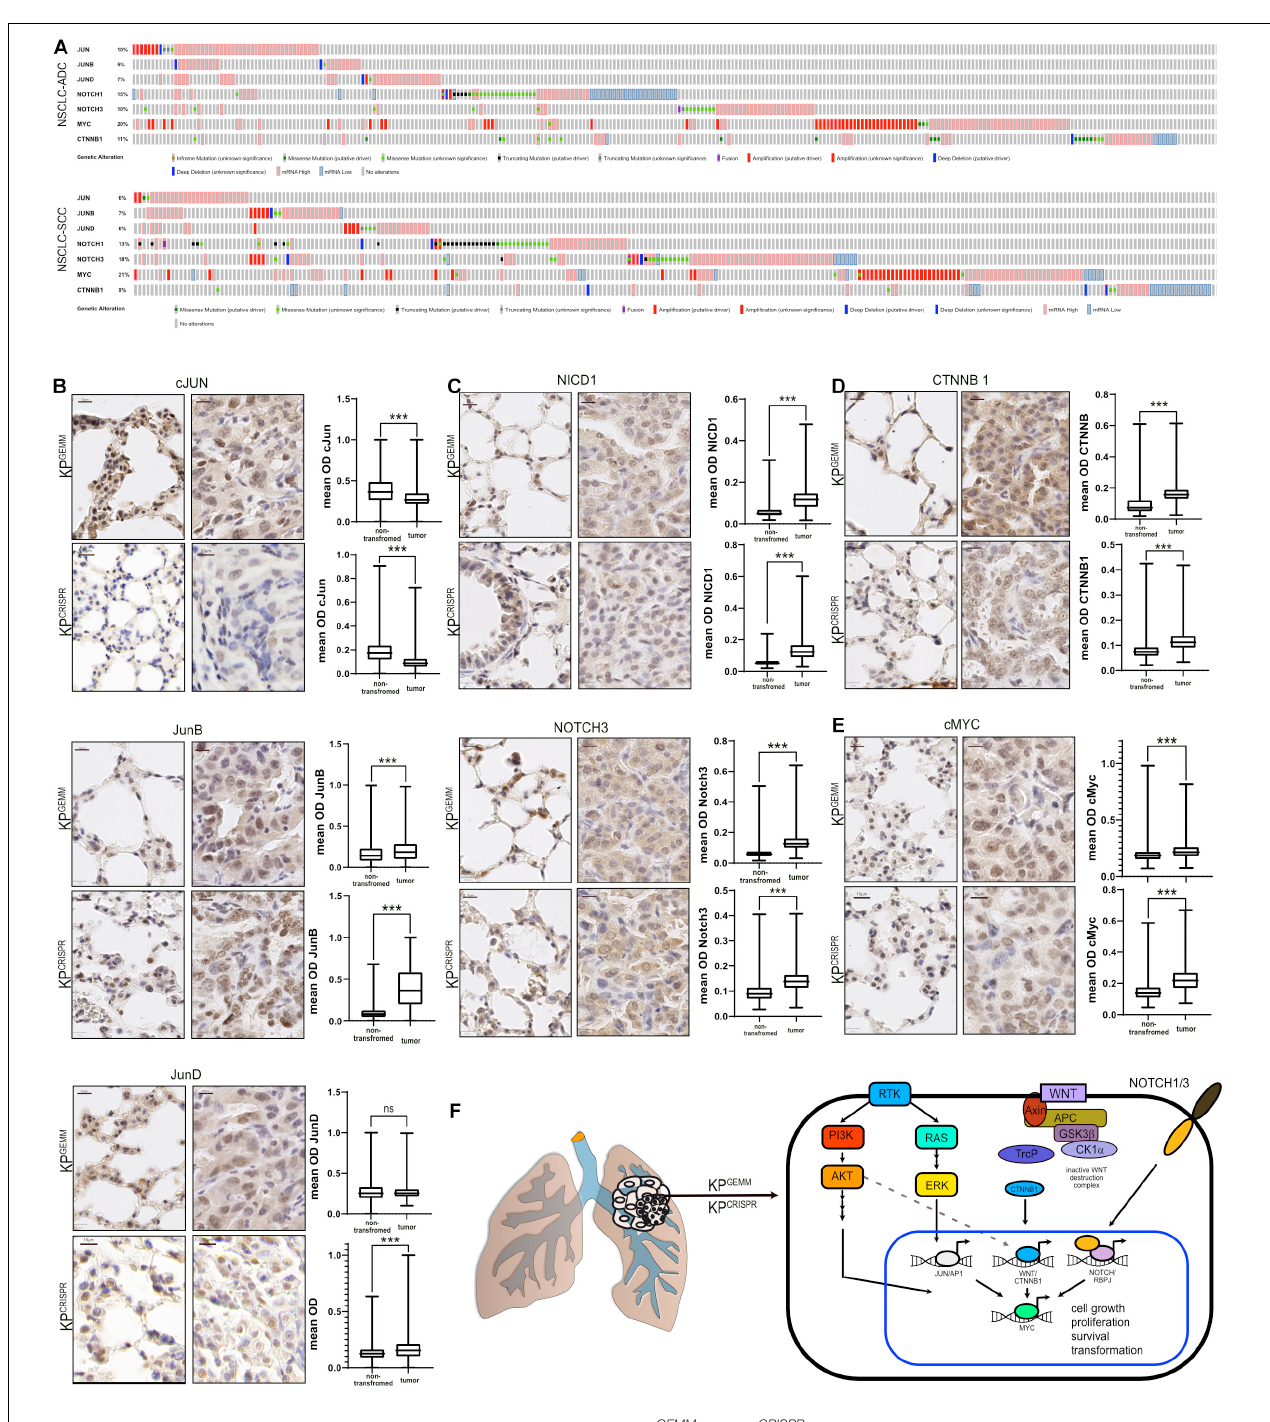
FIGURE 2 | Abundance of NSCLC-associated oncogenic transcription factors in KP GEMM and KP CRISPR shows similarity by immunohistochemistry. (A) Analysis of occurring genetic alterations in lung adenocarcinoma (ADC) and lung squamous cancer (SCC) of associated oncogenes cJun, JUNB, JUND, NOTCH1, NOTCH3, cMYC, and CTNNB1 (www.cbioportal.org). (B) Immunohistochemical staining of cJun, JunB, and JunD in KP GEMM and KP CRISPR . Representative non-transformed trachea and tumor areas. Quantification of relative immunohistochemical staining intensity of cJun, JunB, and JunD in non-transformed lung tissue and tumors. Statistical analysis was performed using unpaired t test. P < 0.0001 (KP GEMM JunD p < 0.8598). Images were quantified using QuPath (version 0.2.8). Boxplots were generated using GraphPad Prism8. KP GEMM n > 5,000; KP CRISPR n > 1,500. P values were calculated using two–tailed t test statistical analysis. (C) Immunohistochemical staining of NICD1 and Notch3 in KP GEMM and KP CRISPR . Representative non-transformed trachea and tumor areas. Quantification of relative immunohistochemical staining intensity of NICD1 and Notch3 in non-transformed lung tissue and tumors. Statistical analysis was performed